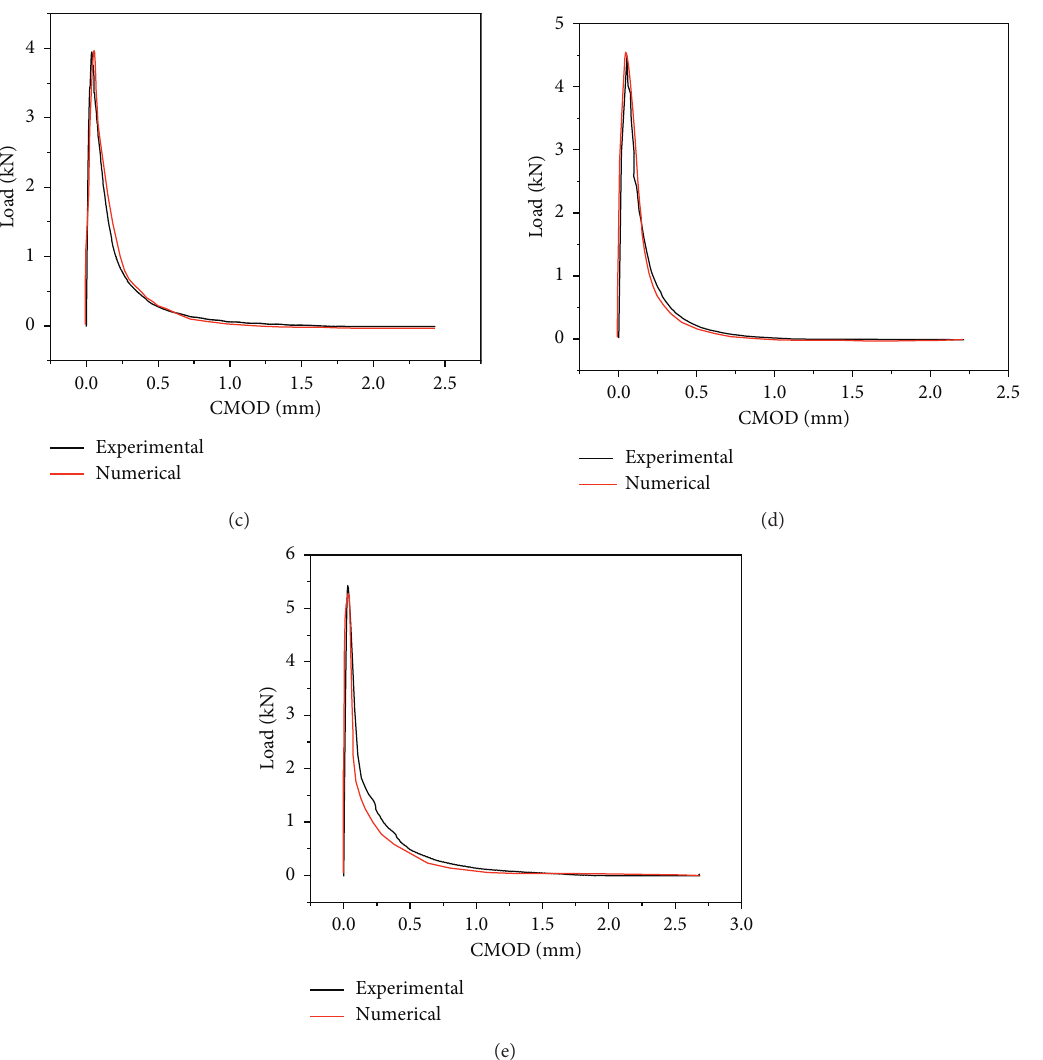
Figure 11: Comparison of the Load-CMOD curves between finite element simulation and experimental test. (a) 0.0001mm/s. (b) 0.001mm/s. (c) 0.01mm/s. (d) 0.1mm/s. (e) 1mm/s.